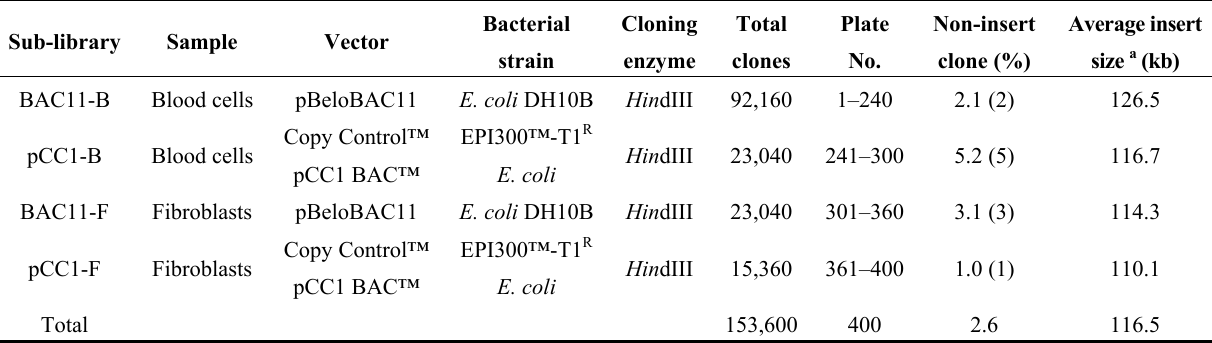
Table 1. Summary of the Siberian tiger BAC library.